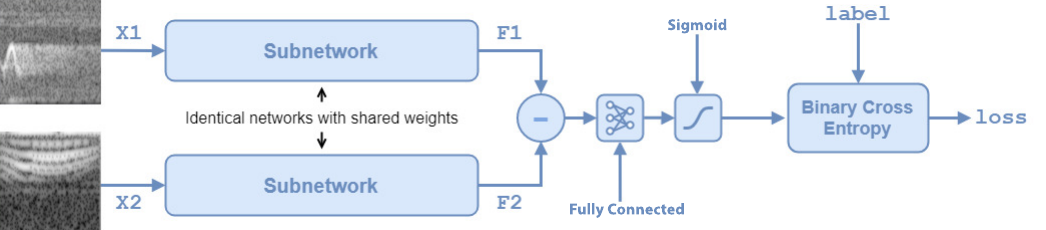
Figure 3. Siamese Neural Network